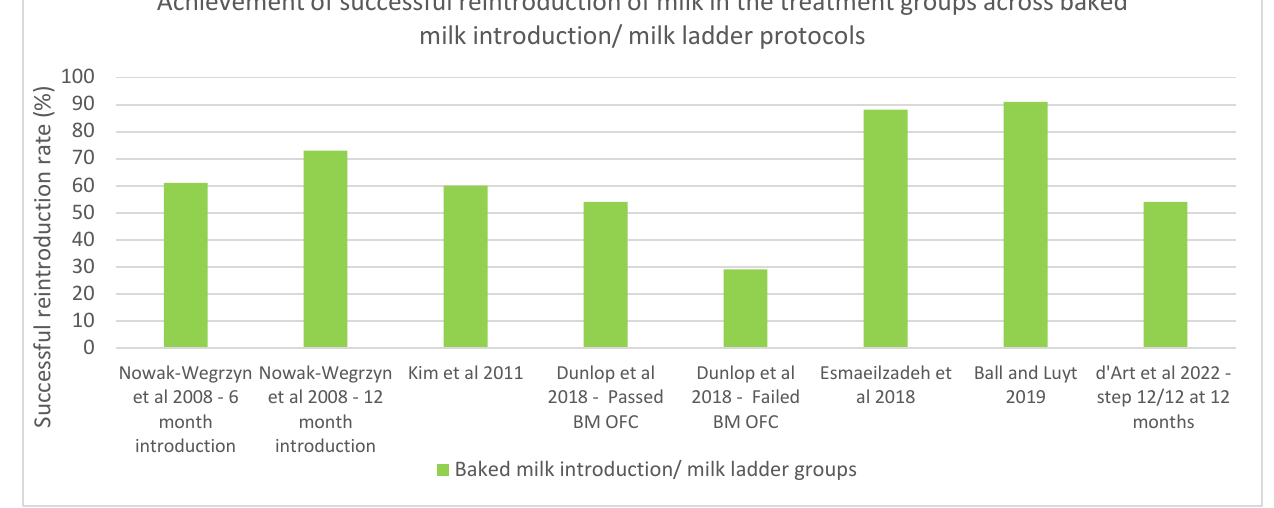
Figure 3. Rates of successful reintroduction to milk using baked milk/milk ladder protocols [40, 42, 45, 46, 51, 52]